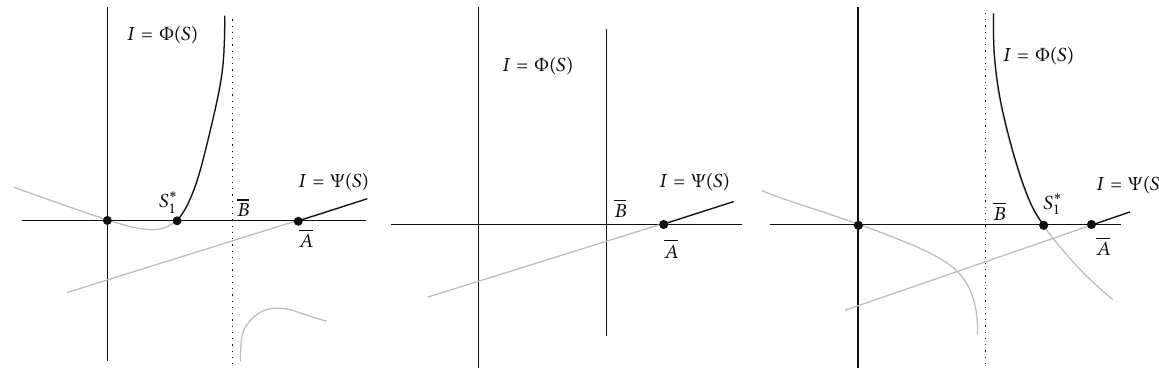
Figure 1: Possible profiles of the 𝑆 -nullcline 𝐼 = Φ(𝑆) and the 𝐼 -nullcline 𝐼 = Ψ(𝑆) and the 𝑆 -nullcline 𝐼 = Φ(𝑆) (in black, their intersection with the positive